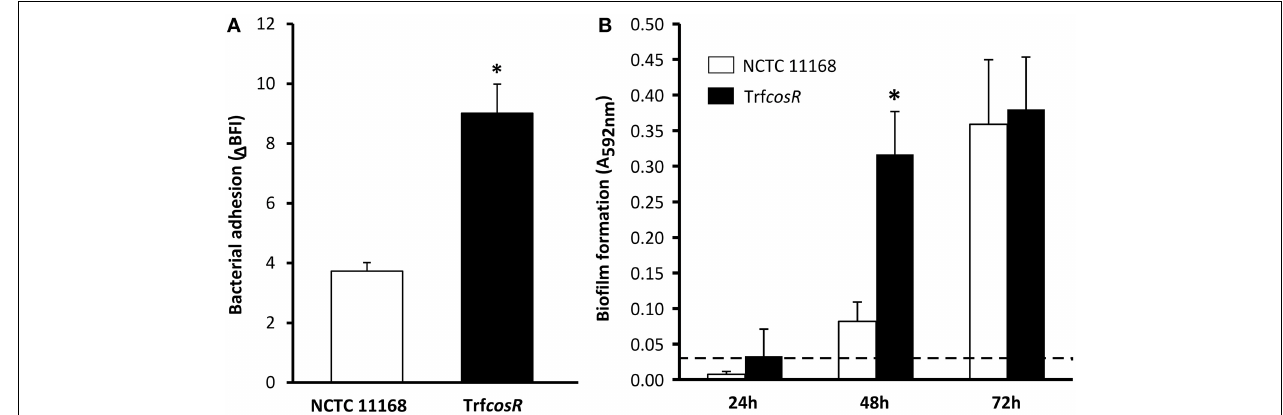
BioFilm Ring Test ® . Biofilm formation was measured in 24-well microtitre plates at 24, 48, and 72h using the crystal violet assay. Error bars represent the standard deviation of three independent experiments. Asterisks indicate significant differences ( P < 0 . 05 ) between the parental strain and the transformant. A dashed line represents detection limit of the crystal violet assay.